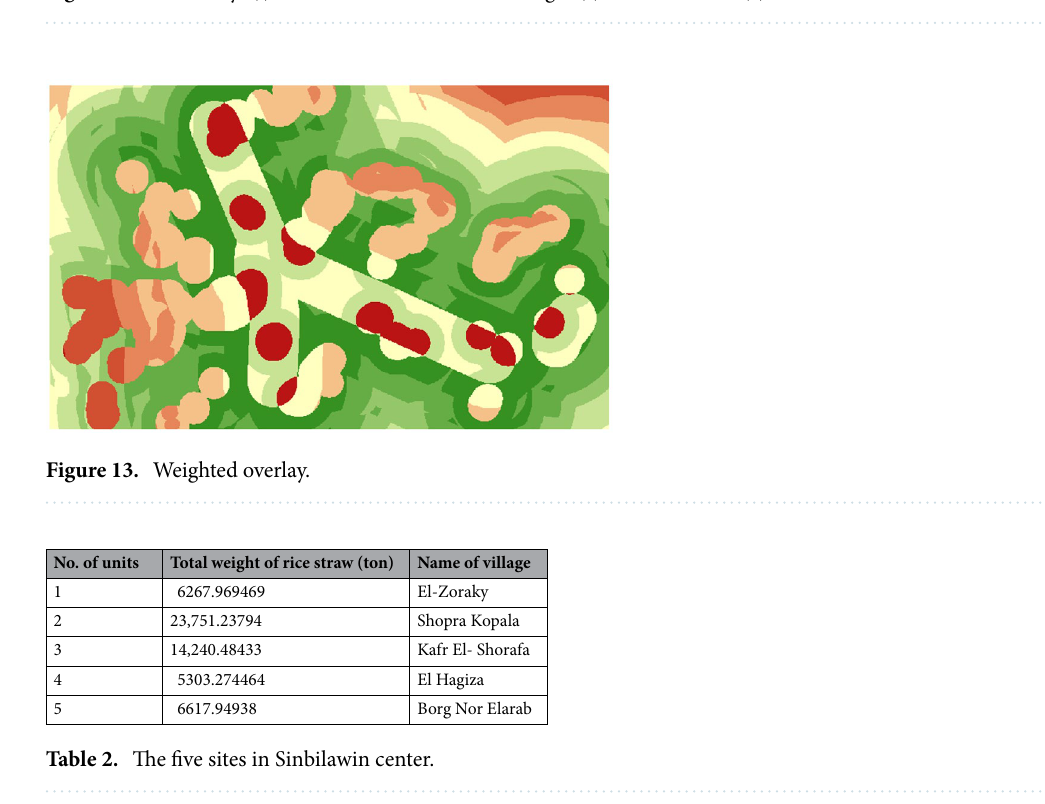
Figure 12. Reclassify: (l) for the best location in all villages (r) for main roads (c) for canals.